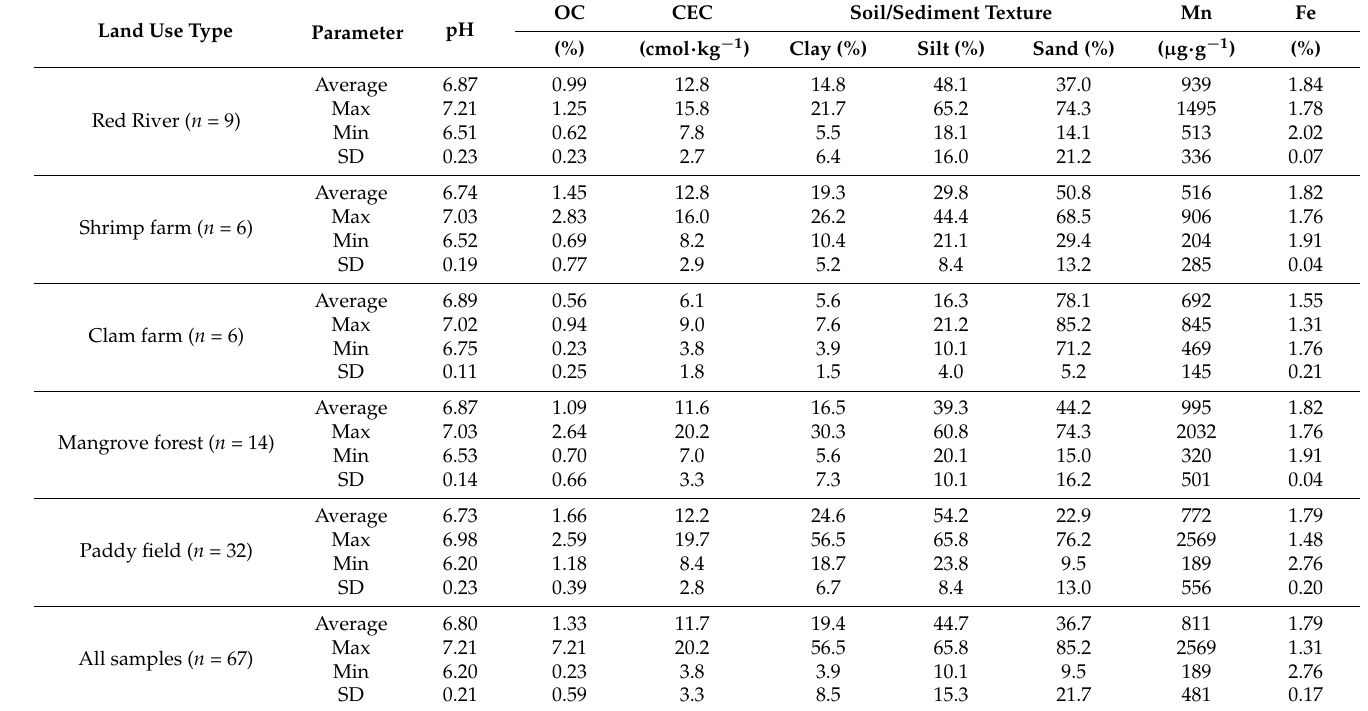
Table 1. Soil properties of samples from different land